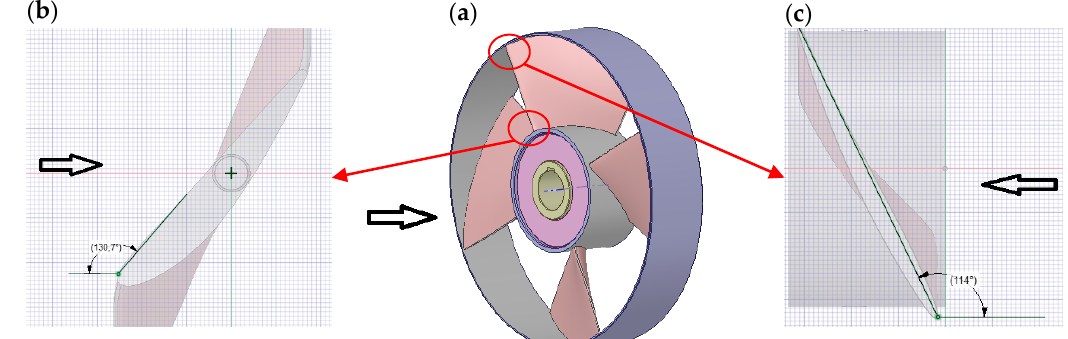
Figure 7. Turbine runner geometry ( a ) with inlet angles: inside angle ( b ) and outside angle ( c ).